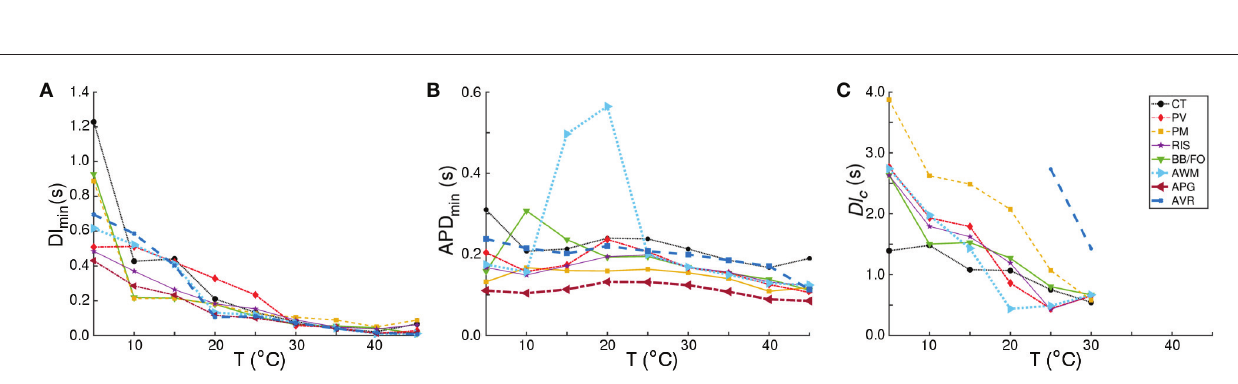
FIGURE 6 | Analysis of the APD restitution curves for all atrial regions. Temperature-dependence of (A) DI min , (B) APD min , and (C) DI c , as measured from CT, BBFO, PM, PV, RIS, AWM, APG, and AVR. DI min shows a general hyperbolic decrease with increase in temperature. APD min on the other hand, increases slightly with decrease in temperature, reaching a maximum around 20 ◦ C and then decreasing again to approximately its value at 37 ◦ C. The sudden large deviation in APD min around 15 − 20 ◦ C for AWM arises from the atypical behavior of its corresponding APD restitution curve (see Figure 5F ). DI c increases almost linearly with decrease in temperature for each region, although the rate of increase is